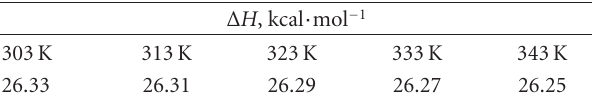
Table 4: The enthalpy of adsorption ( Δ H ) for mild steel in 1 M HCl in the presence of 1 × 10 − 3 M trans-4-hydroxy-4 (cid:2) -stilbazole inhibitor at various temperatures